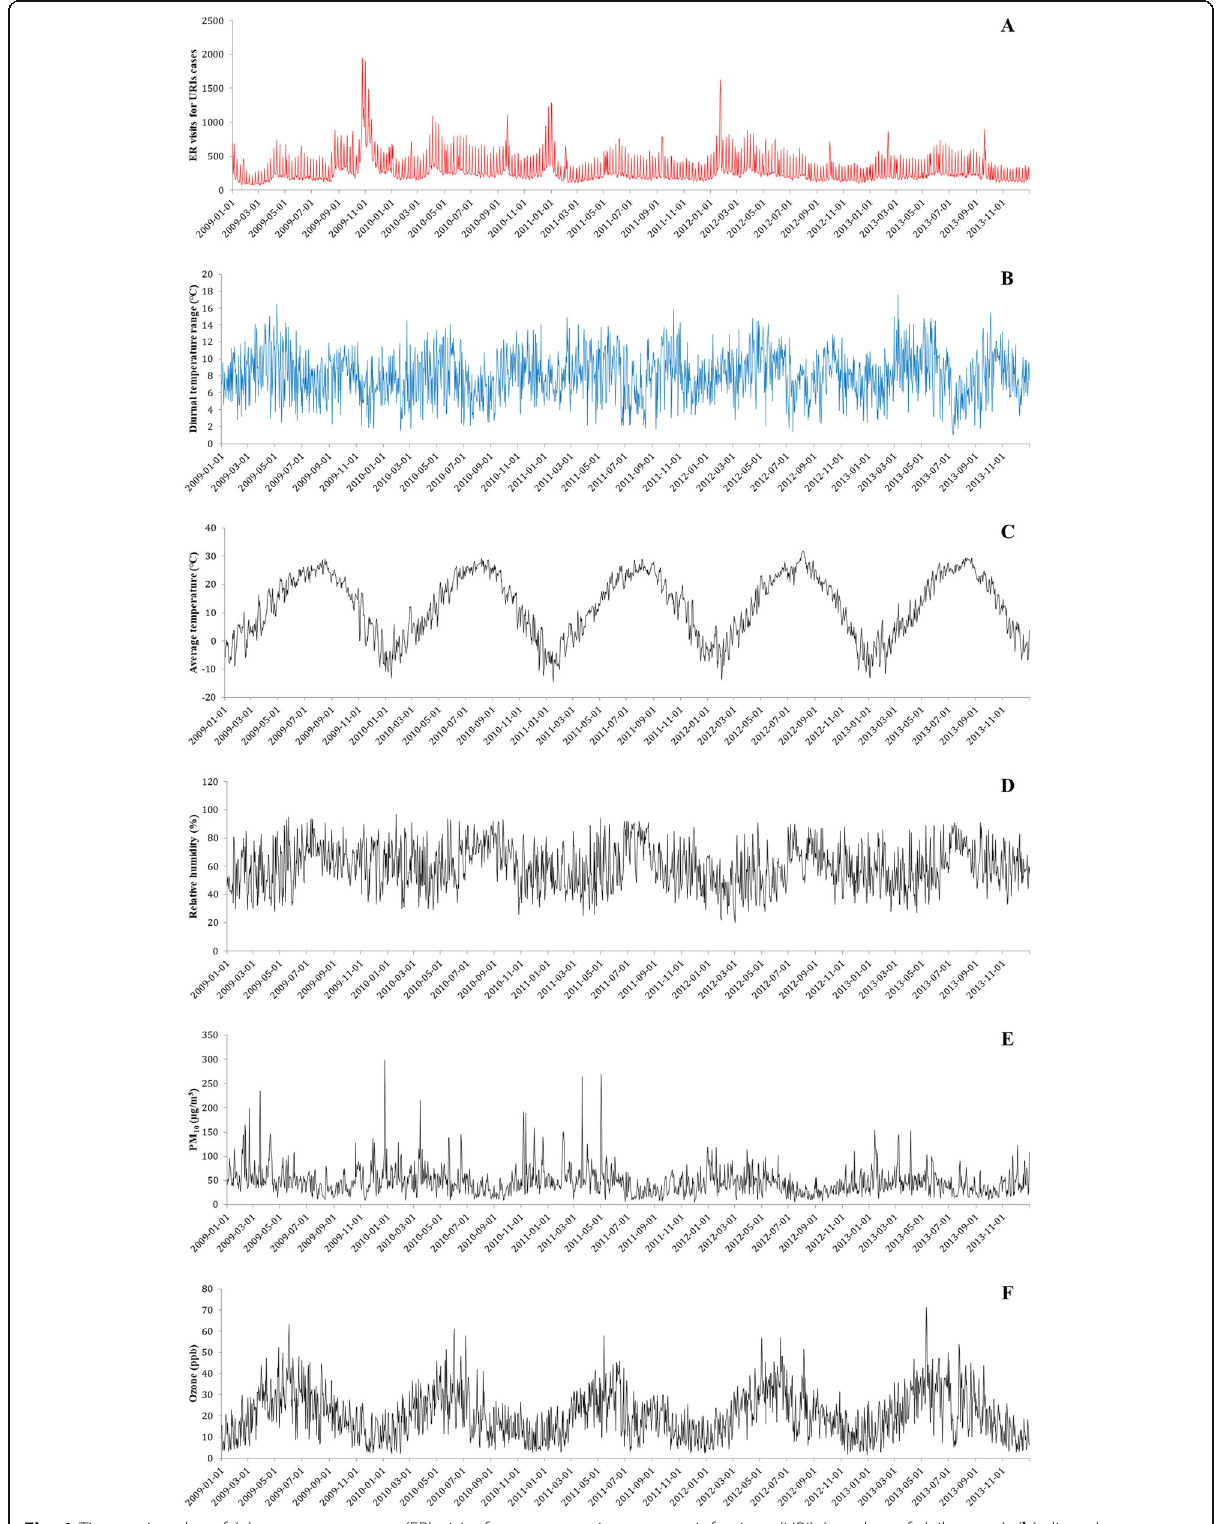
Fig. 1 Time series plot of ( a ) emergency room (ER) visits for upper respiratory tract infections (URI) (number of daily cases), ( b ) diurnal temperature range (DTR), ( c ) average temperature, ( d ) relative humidity, ( e ) particulate matter with a median aerometric diameter < 10 microns (PM 10 ), and ( f ) ozone (O 3 ) in Seoul, Korea, 2009 to